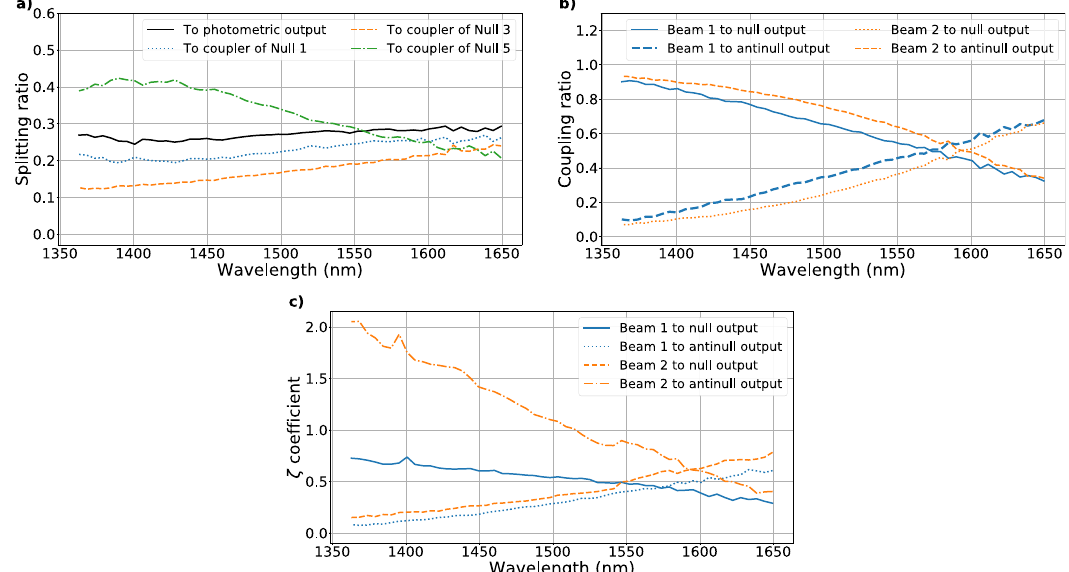
Fig. 4 Splitting, coupling ratios and ζ coef fi cients of the beam combiner. a Splitting ratios of beam 1 between the photometric output and the three couplers with respect to wavelength. b Coupling ratios of the coupler combining the beams 1 and 2 with respect to wavelength. c ζ coef fi cients for beams 1 and 2 for the outputs of Null 1 with respect to